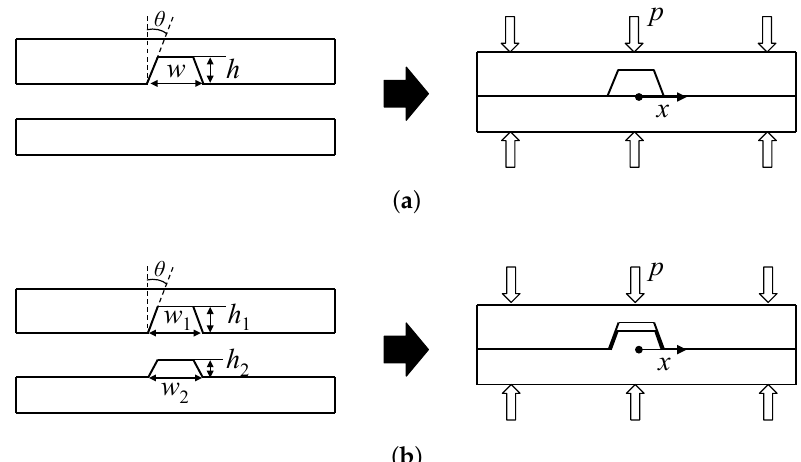
Figure 1. Schematics of ( a ) the conventional thermal bonding method; and ( b ) interference-assisted thermal bonding